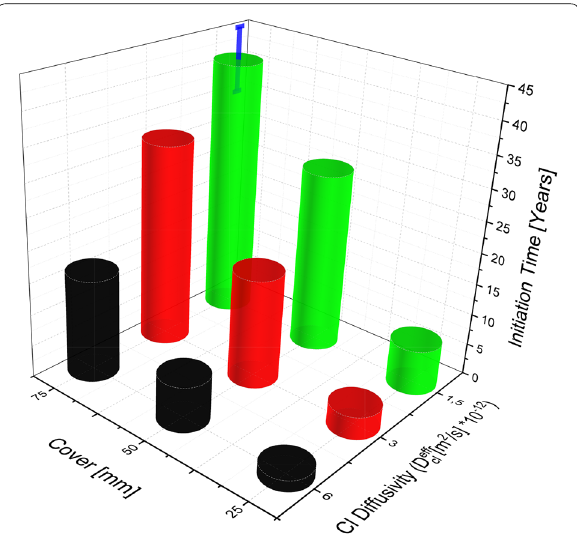
Fig. 8 A qualitative variation of initiation time with concrete quality and placement of rebar from the exposure surface.